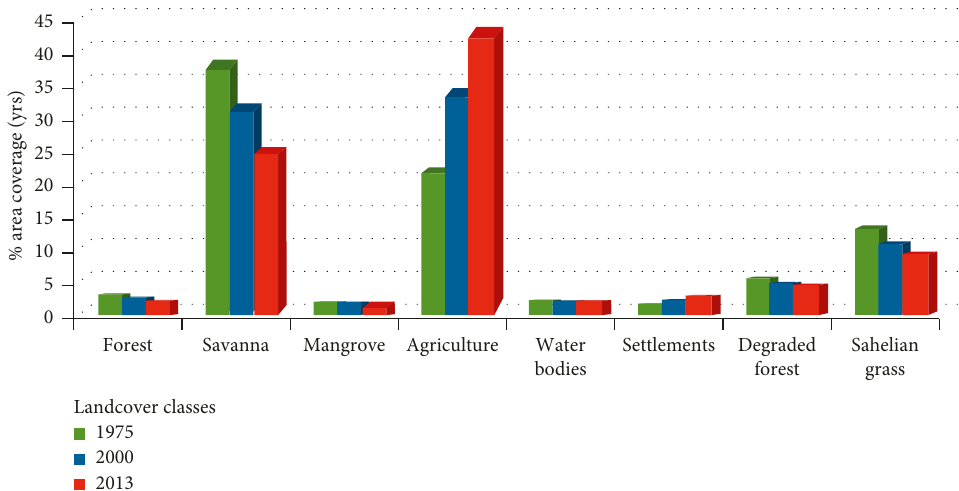
Figure 9: Changes in landcover area from 1975 to 2013 (adapted and modified from [34, 35]).